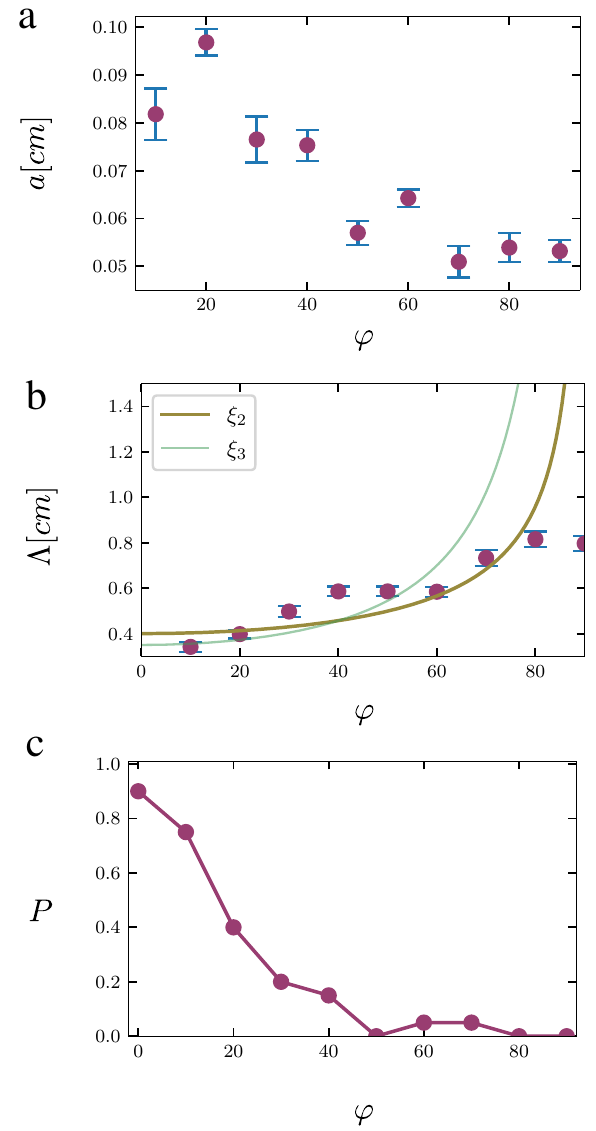
Figure 7. Experimental results: ( a ) Change in amplitude as a function of tilt angle. ( b ) Change in wavelength as a function of tilt angle compared to Eq. (18) (thick dark-yellow line) and Eq. ((19)) (thin green line). ( c ) Probability of a root to form coils as a function of the angle. In all cases the sample size was n = 20 and the standard error is represented by vertical